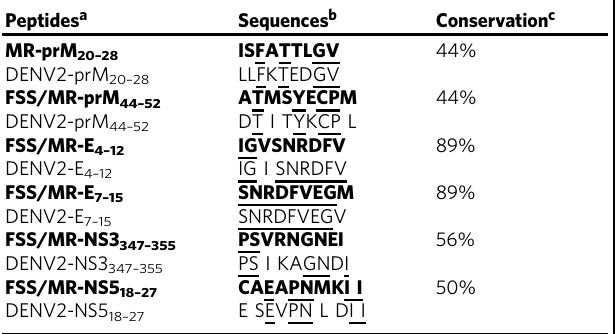
Table 1 ZIKV epitopes and DENV2 variants Peptides a Sequences